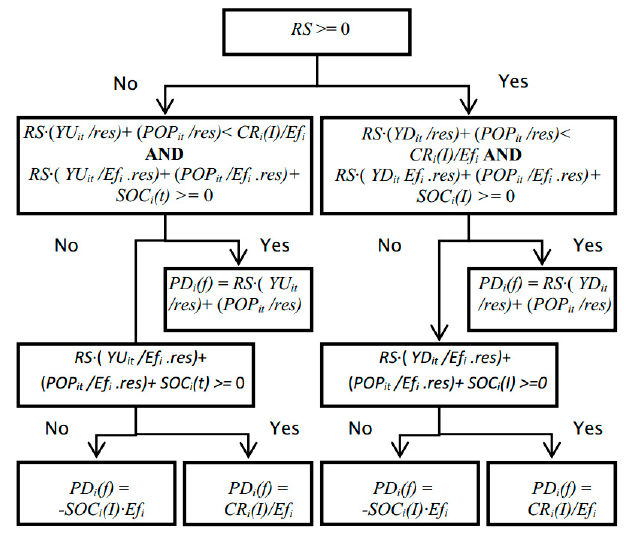
Figure 2. Power draw calculation of a battery after performing the regulation Figure 1. Power draw calculation of a battery after performing the regulation service.